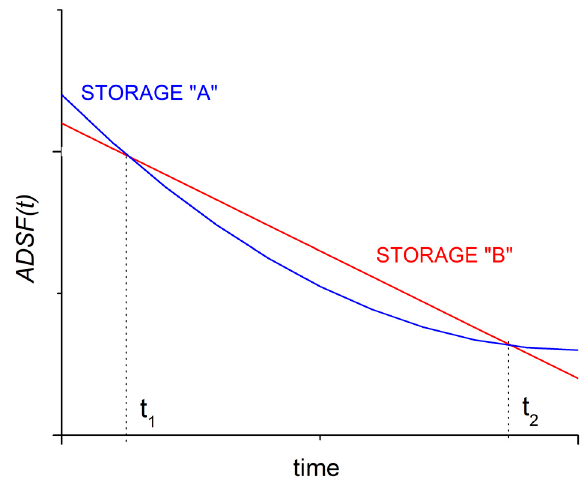
Figure 2. Using the time-dependent function ADSF ( t ), it can be decided which kind of energy storage device is preferable when the discharging of the fully charged storage devices is started after an unloaded period. Starting discharge before time t 1 , then storage A is better, starting discharge between t 1 and t 2 , storage B is preferable while starting the discharge after t 2 , storage A would again recover more electricity.